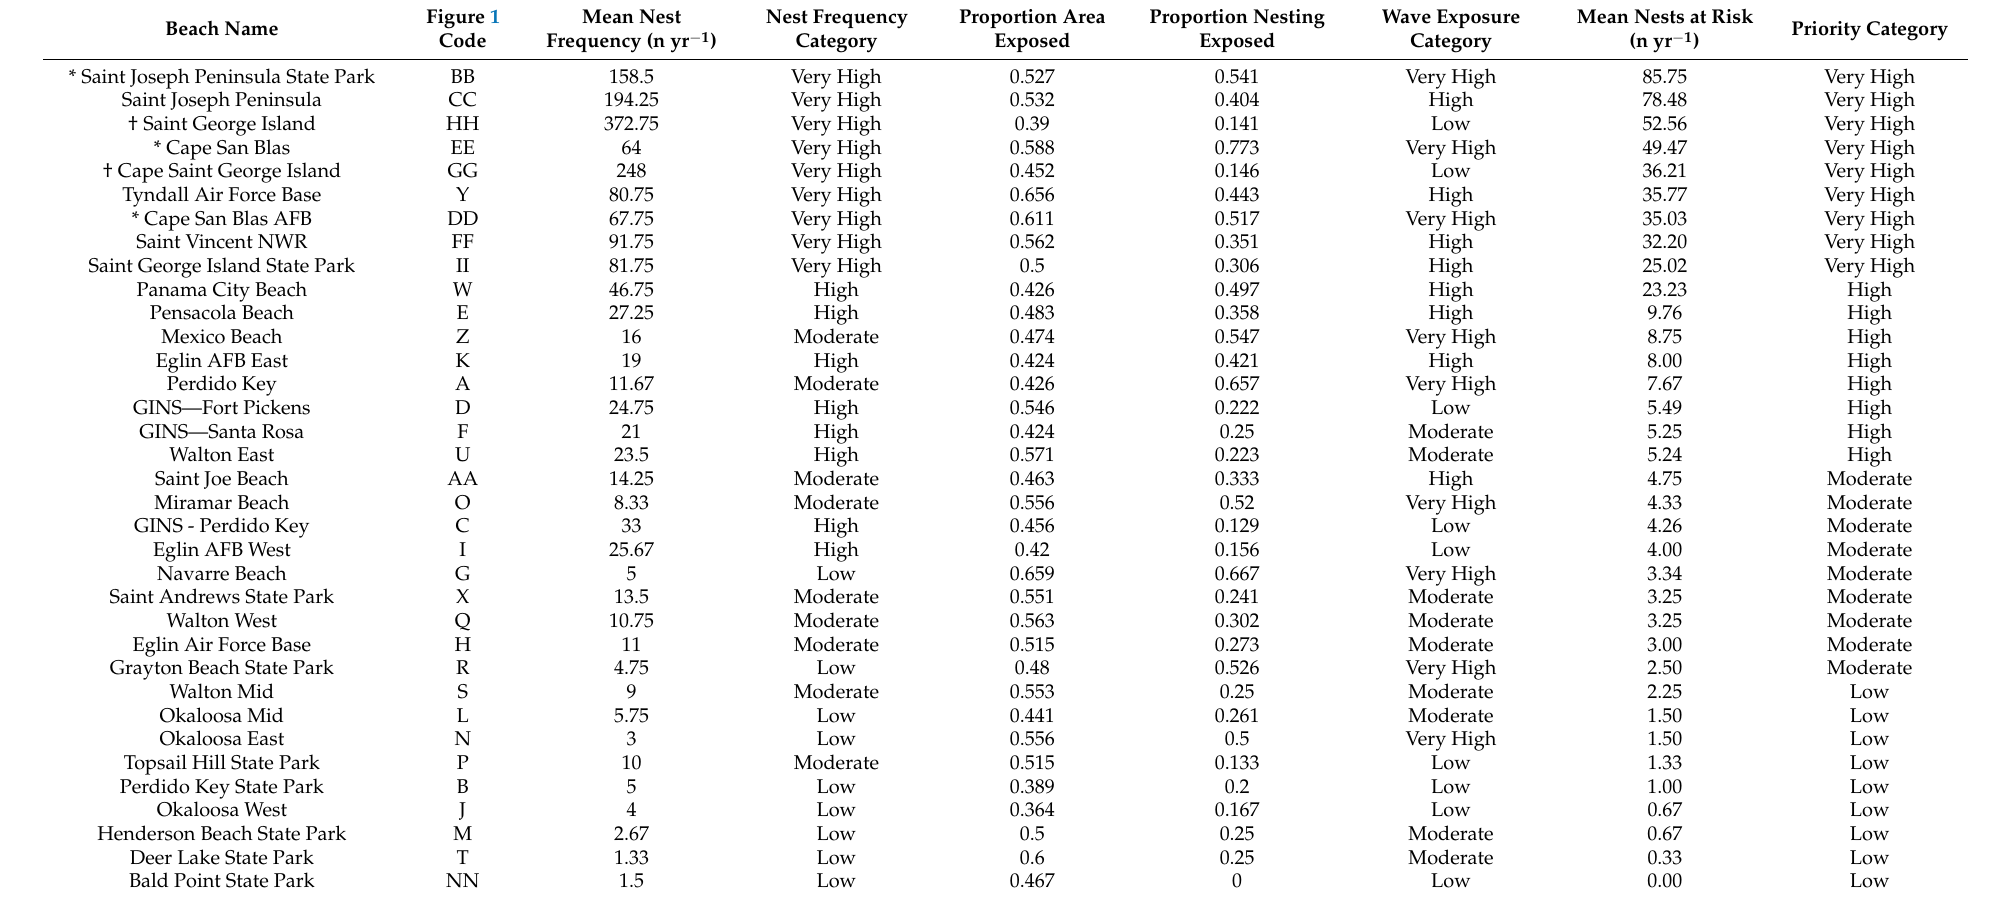
Table 3. Nesting beach prioritization for future consideration of wave exposure impacts based on the mean nesting frequency and the proportion of nest GPS locations exposed to modeled wave activity during the 2016 to 2019 nesting seasons. Nesting beaches are presented according to the mean number of at-risk nests (i.e., nest frequency multiplied by the proportion of nesting exposed). * Denotes nesting beaches in the highest quartile of nesting frequency and highest quartile of wave exposure. † Denotes nesting beaches in the highest quartile of nesting frequency and lowest quartile of wave